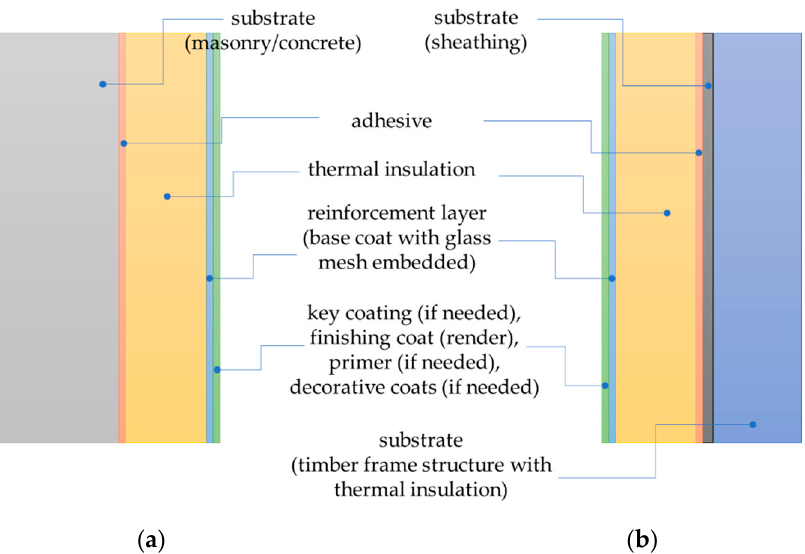
Figure 1. ETICS on ( a ) masonry or concrete wall, ( b ) on wood frame wall. Example of purely bonded ETICS.